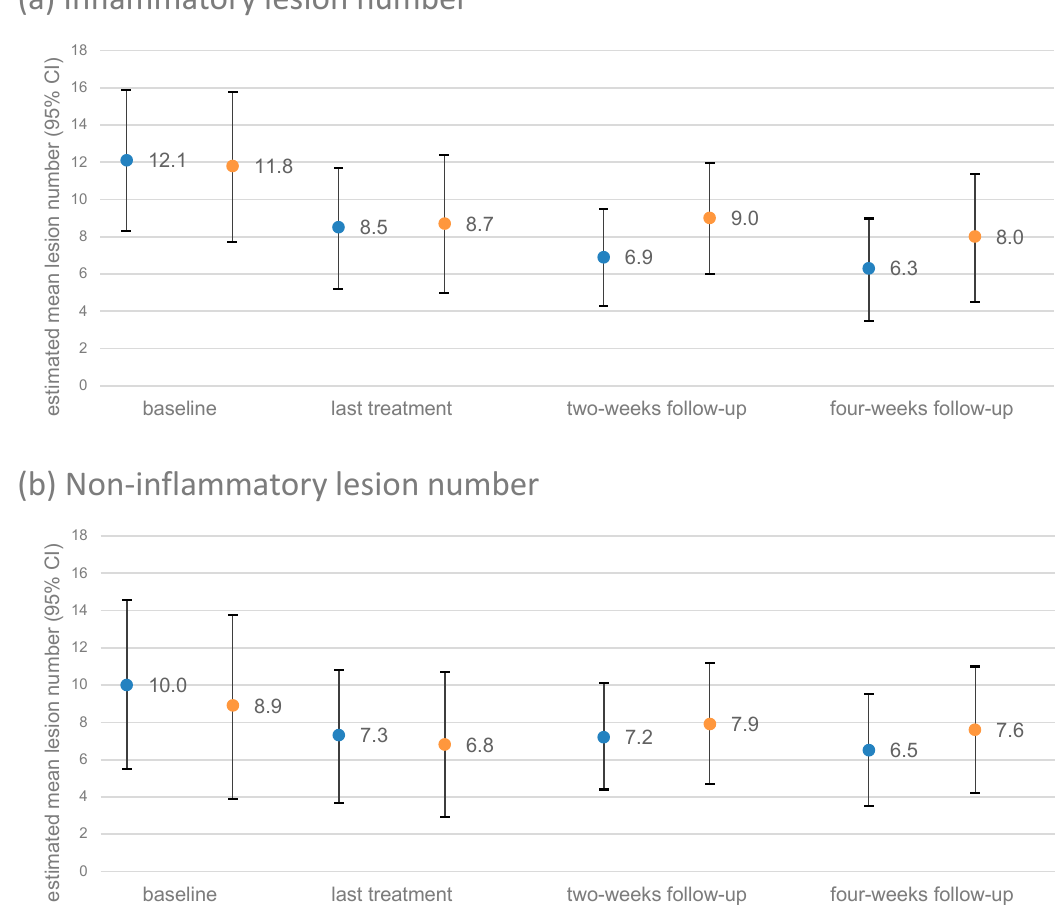
Figure 3. Course of the number of inflammatory lesions ( a ) and non-inflammatory lesions ( b ). Blue = treated side; orange = untreated side. Mixed linear models (MLMs) were used to compare the number of lesions between the measurement time points. MLMs additionally included the fixed effects of the number of applied plasma treatments and the interaction of the time and number of applied plasma treatments (data not shown). Presented are the estimated/adjusted means with a corresponding 95% confidence interval (CI) out of four separate MLMs. In total, 29 patients had a valid lesion count; 25 patients had 10 plasma treatments, and 4 patients 8 treatments. Only inflammatory lesions on the treated side were significantly reduced from baseline to the last treatment ( − 30%, p = 0.020), to the two-week follow-up ( − 43%, p = 0.002) and the four-week follow-up ( − 48%, p = 0.040).